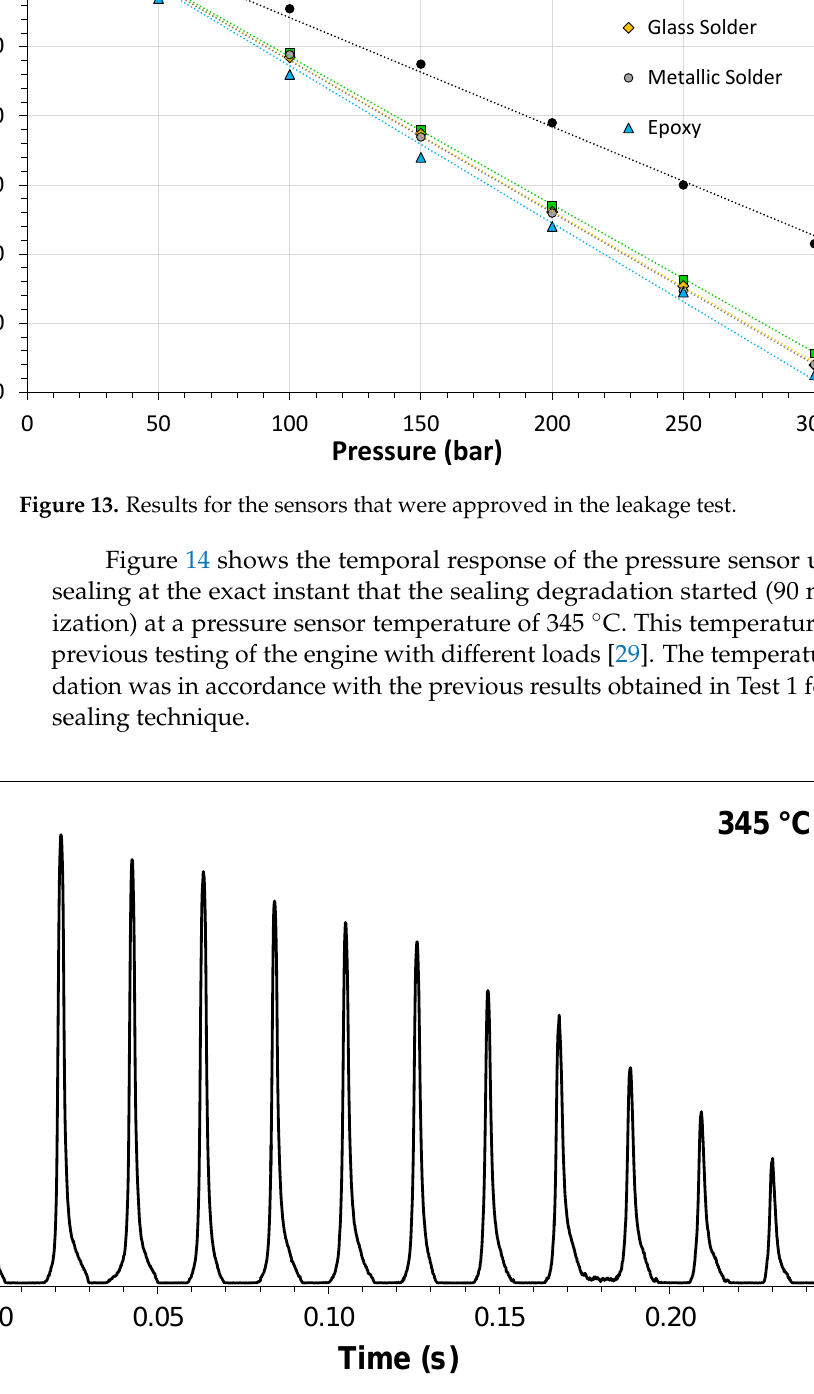
Figure 14. Temporal response of pressure sensor using nickel-plating sealing in the moment that the sealing degradation started.